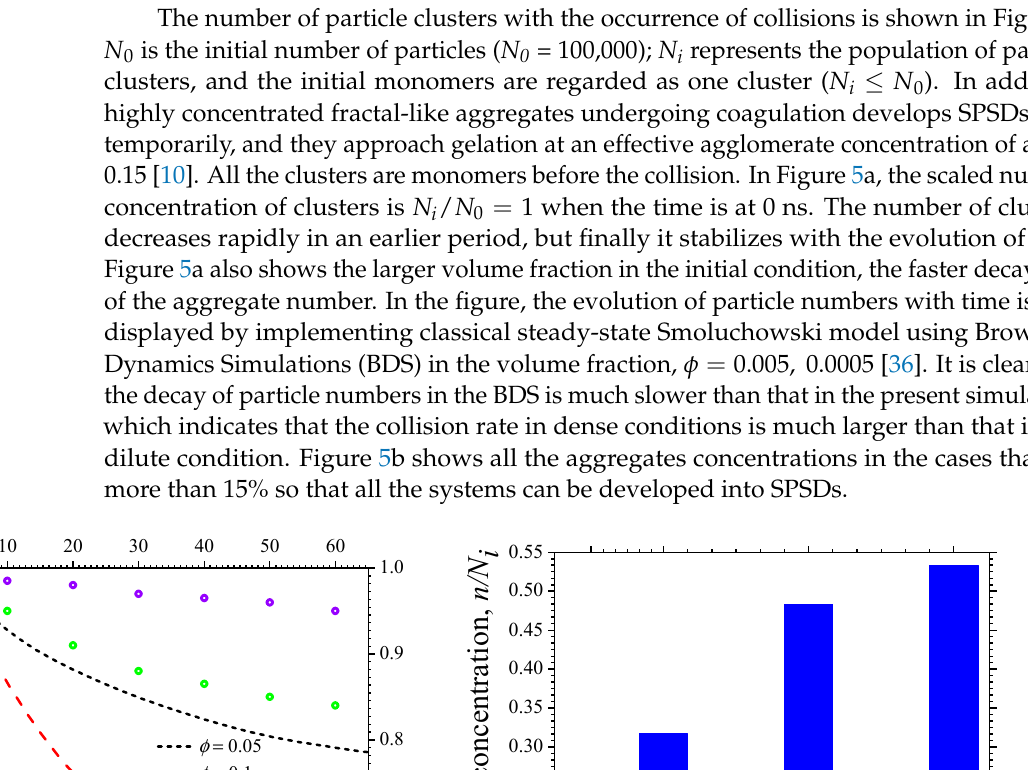
Figure 4. The CPU velocity and total walk time in the same running range.